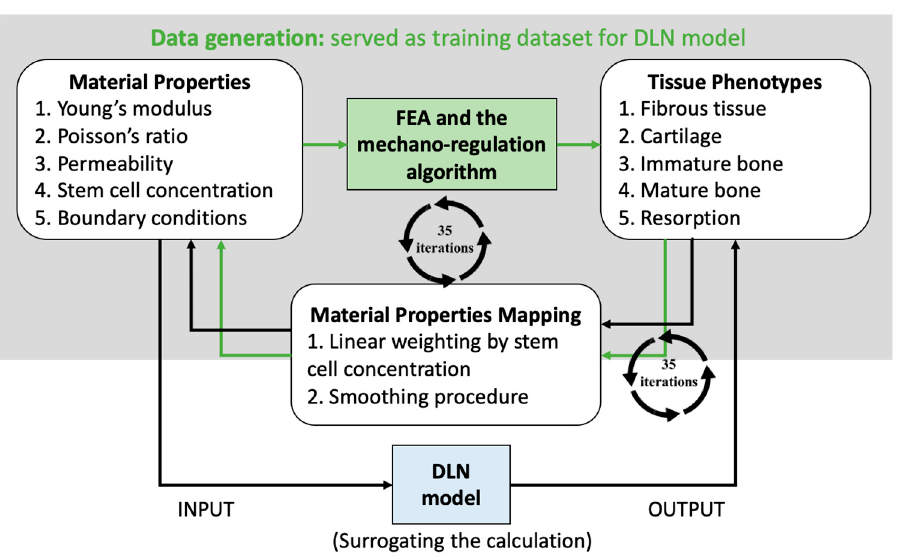
Figure A3. Procedure of tissue differentiation prediction based on the proposed DLN model.